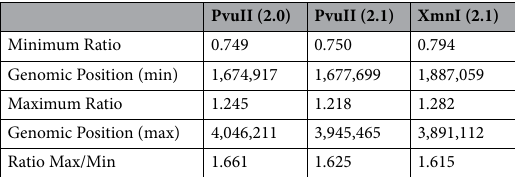
Table 4. Ratios of Exponential to Stationary Phase Reads.